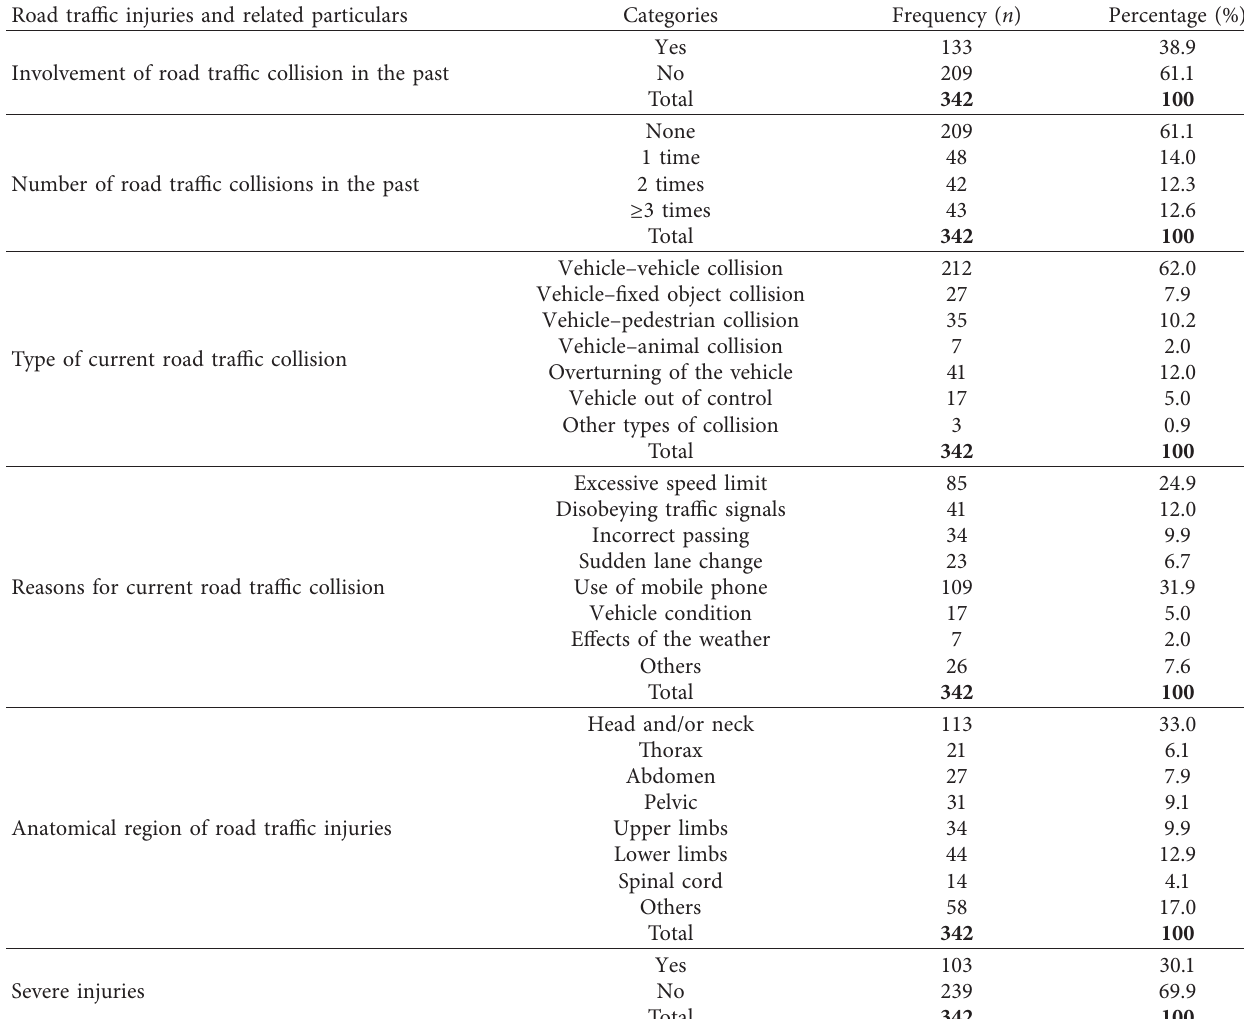
Table 3: Road traffic injuries and related particulars ( n �